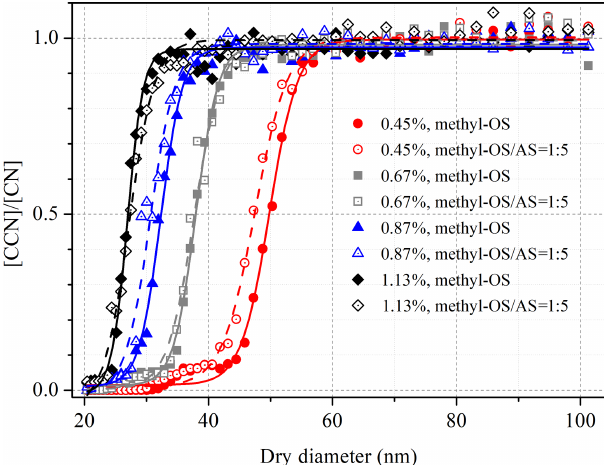
Figure 3. Activation fractions of methyl-OS and its internally mixed aerosol particles with ammonium sulfate (AS) as a function of dry particle diameter at four